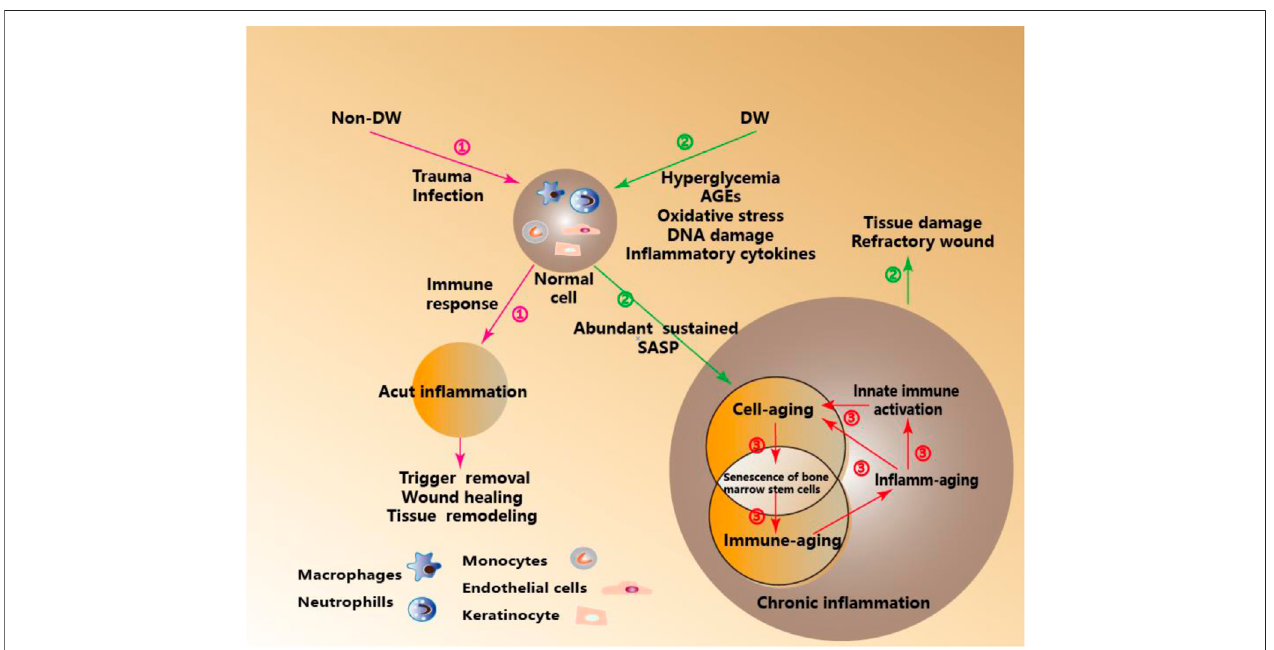
FIGURE 1 | Immune- Aging and In fl amm-Aging under Metabolic Stress in DW. ① Acute in fl ammation-mediated wound healing, tissue remodeling, and other orderlyoutcomesundertheimmuneresponseinNon-DW. ② In fl amm-aginginducedbymetabolicpressuremediatedtissuedamageandhinderswoundhealinginDW. ③ In the process cell senescence in DW, adaptive immunity signi fi cantly decreased, which is called immune-aging, while innate immunity is activated, thus inducing a unique pro-in fl ammatory response, which is called in fl